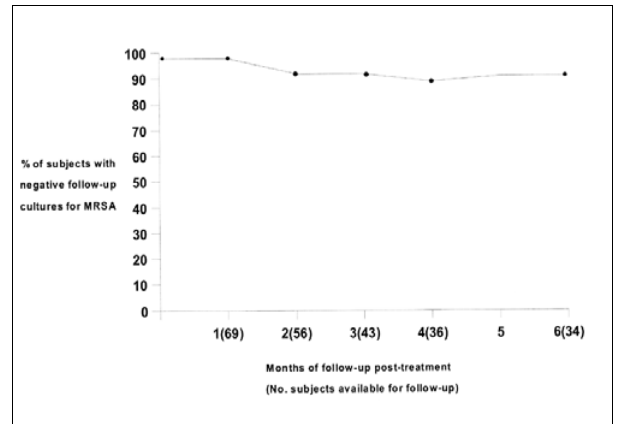
Figure 1) Proportion of patients with negative follow-up cultures for methicillin-resistant Staphylococcus aureus (MRSA) one to six months following decolonization